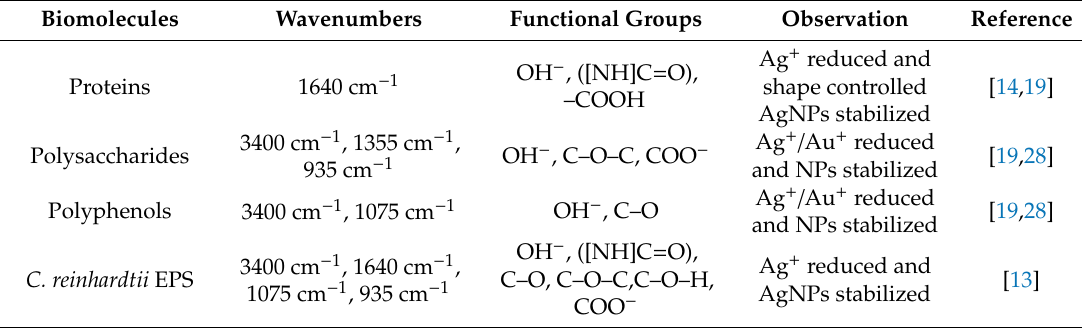
Table 1. Biomolecules and functional groups in EPS and their role in AgNP biosynthesis.